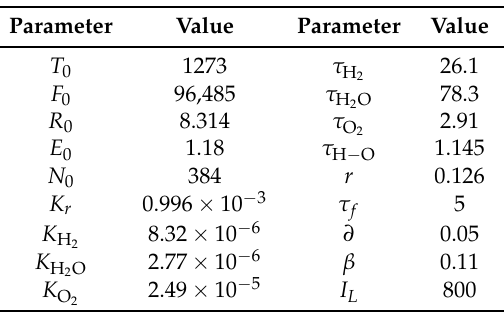
Table 1. Parameters of the SOFC system